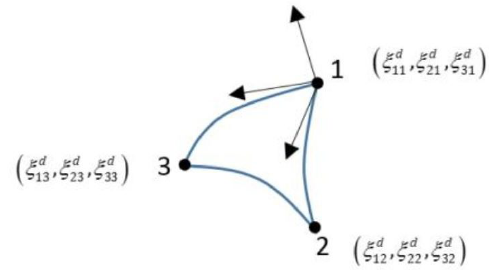
Figure 6: A general curved shell triangular finite